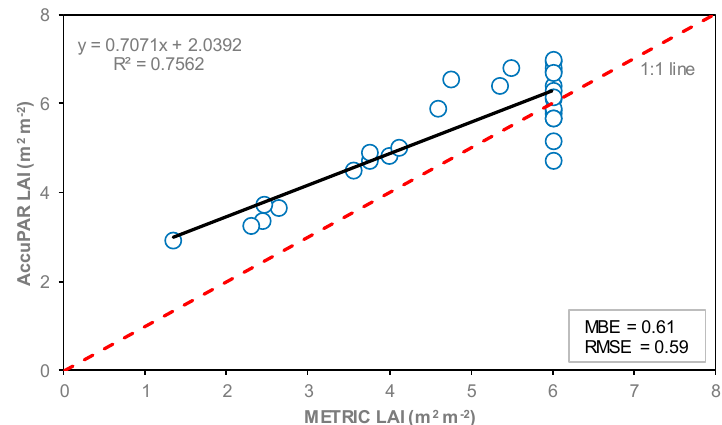
Figure 7. Relationship between LAI values estimated with the METRIC model and LAI values measured with AccuPAR in five observation locations during the 2016 corn growing season. The red dashed line represents the 1:1 line.